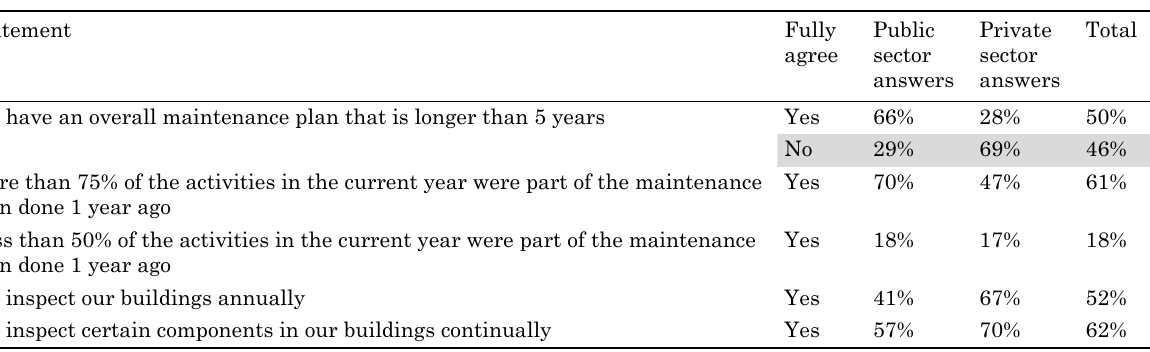
Table 5. Maintenance planning and